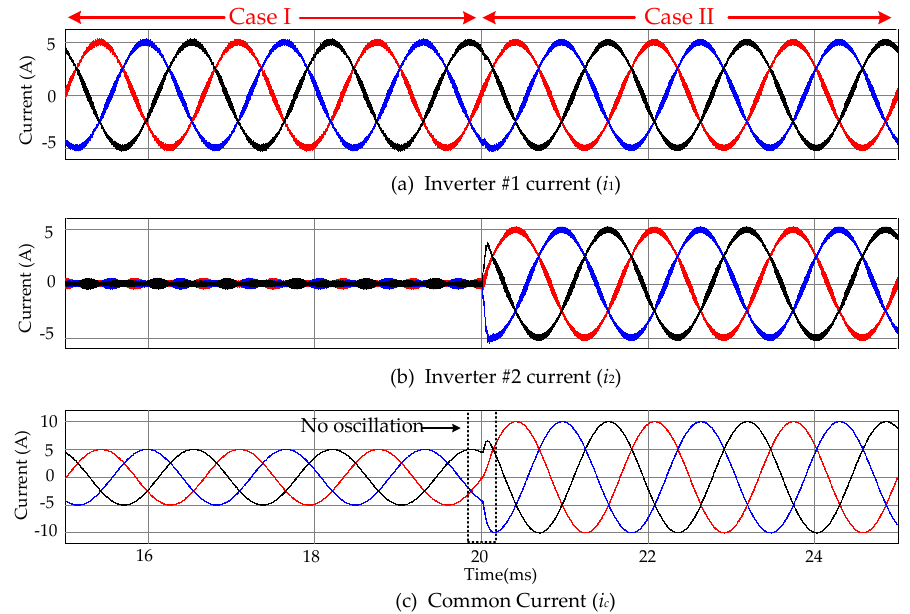
Figure 10. Simulation results for Cases I and II under the proposed scheme.